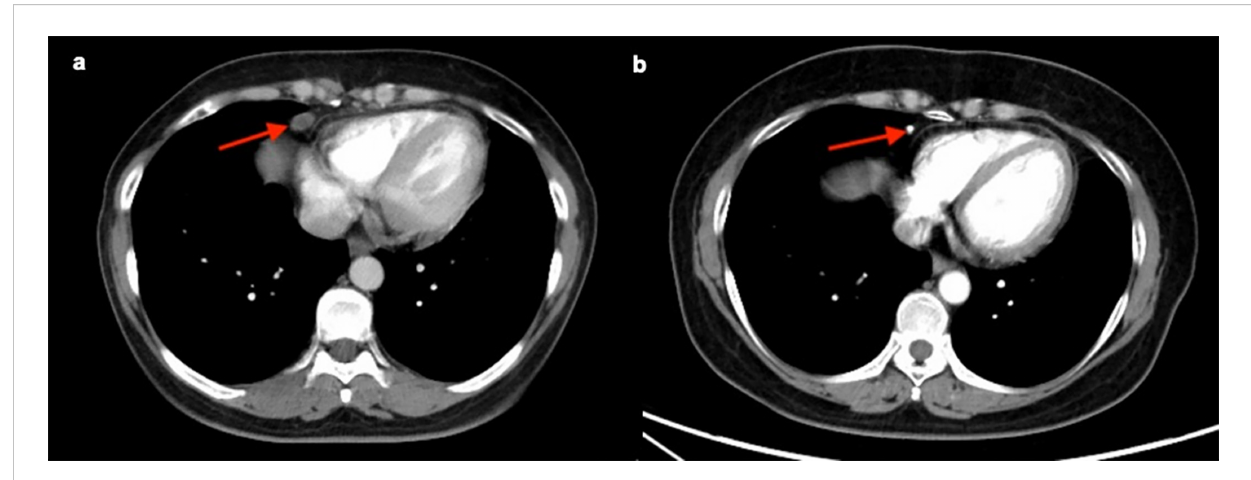
FIGURE 6 Staging CT image of a patient with FIGO stage IIIC ovarian cancer who presented with an enlarged cardiophrenic lymph node (CPLN) of 9.7 mm in the short axis (A) . The CPLN had decreased with a short axis diameter of 3.0 mm 4 years later, and the patient had no recurrence (B)